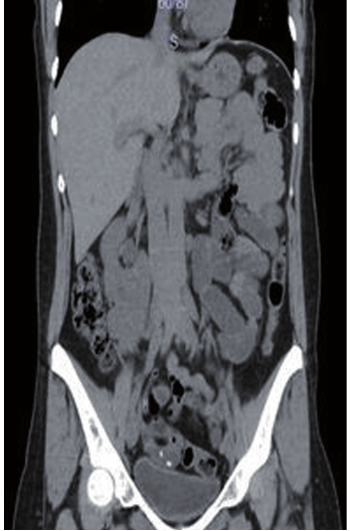
figure 2 - computed tomography scan of right